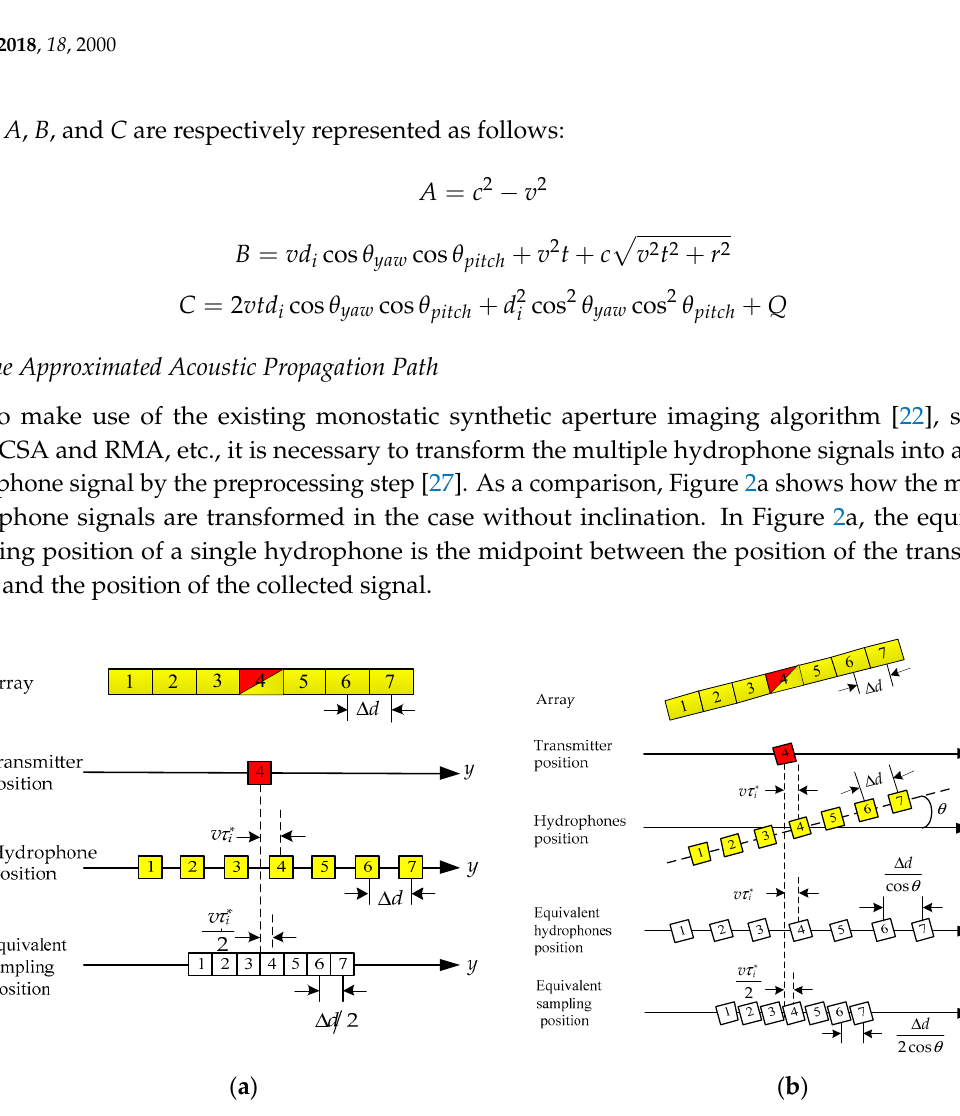
Figure 2. The position of the transmitter and the hydrophones, and the azimuth position of the phase center, when the sampling point is uniformly distributed (7 hydrophones in this example). ( a ) Side-looking array; ( b ) Inclined array.